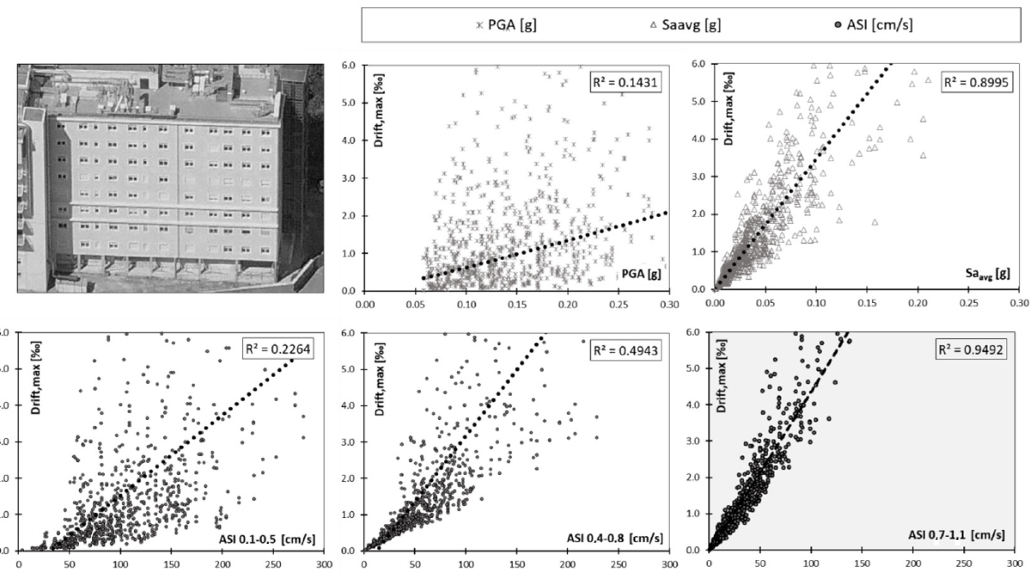
Figure 14. Results of the SMAV analysis of CS2.